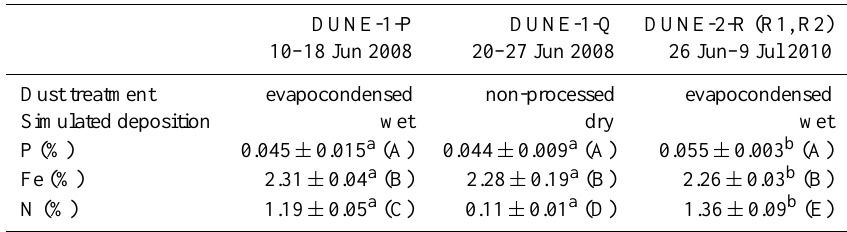
Table 1. Particulate P, Fe and N (%, in weight) in the EC and non-EC dust used during DUNE. Means that were not significantly different for a given chemical element between the different experiments ( p >0.05) were labeled with the same letter (in